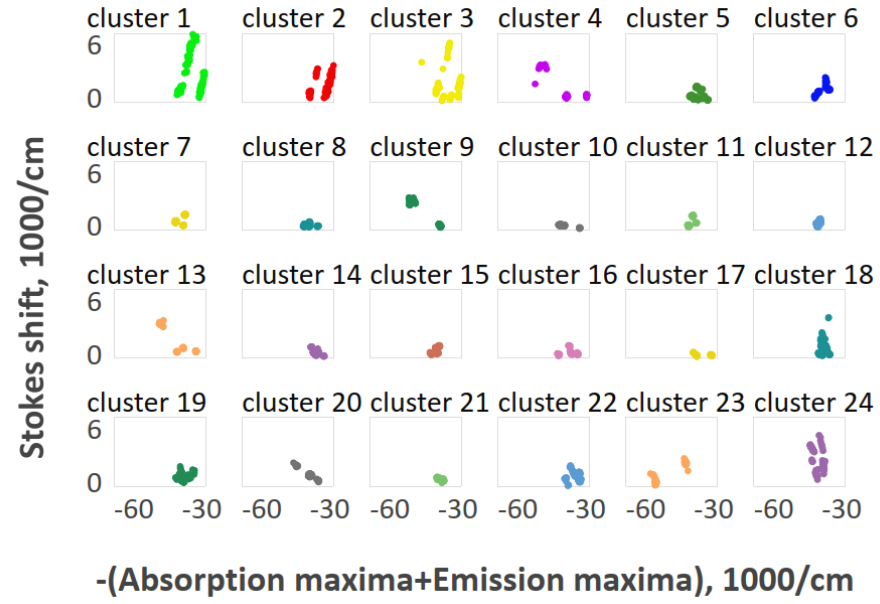
Figure 9. Stokes shift versus − (absorption maxima + emission maxima) diagram in terms of 1000/cm for a 24-cluster dataset of 115 BODIPYs, in decreased order, of parameter A.